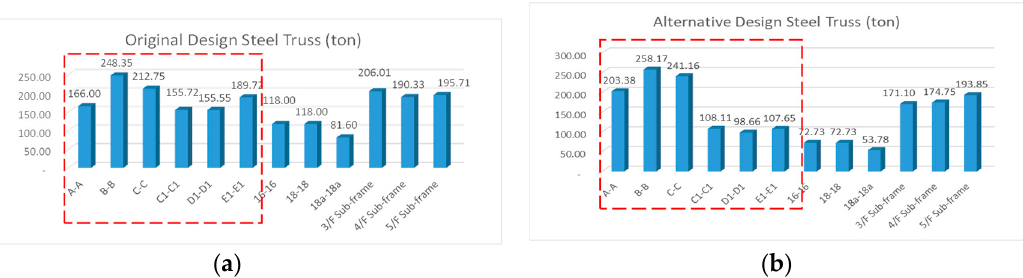
Figure 7. Distribution of steel weight. ( a ) Original steel truss scheme; ( b ) Optimal steel truss scheme.